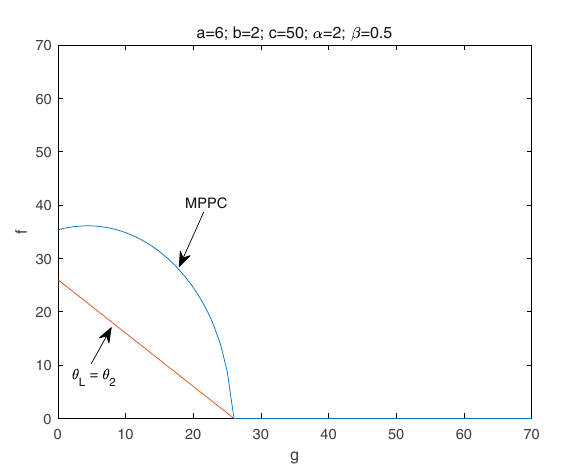
Fig. 5 Lower bound when θ L = θ 2